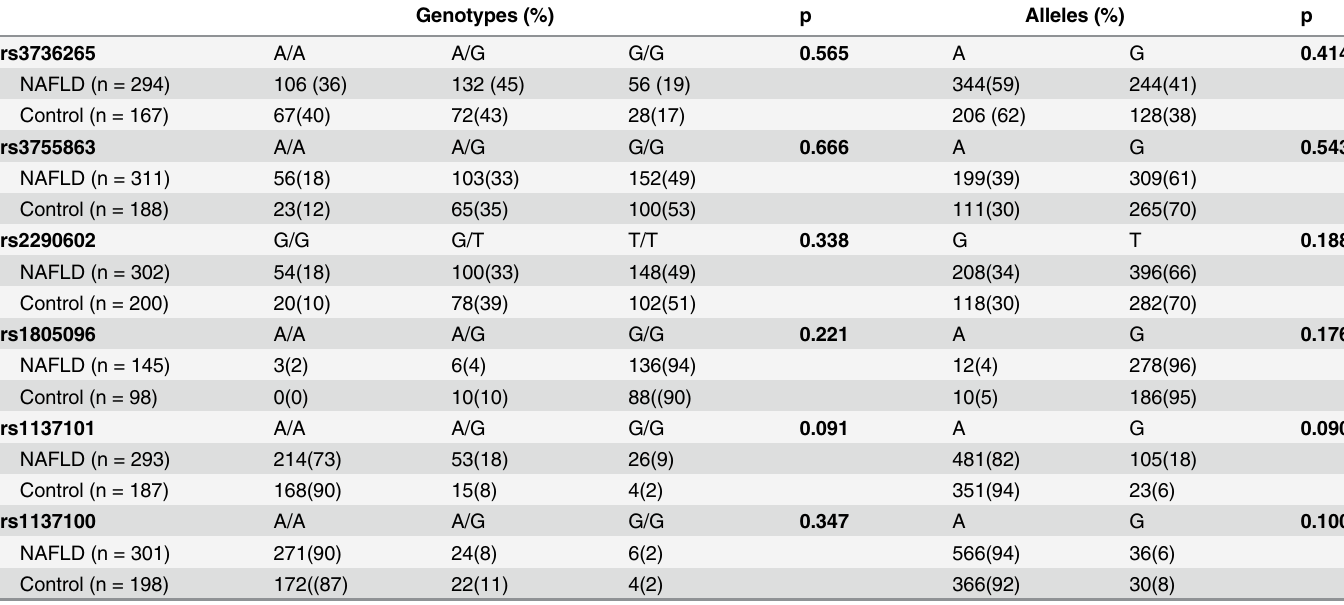
Table 2. The Genotypes and Allele Distribution of the PPARPGC1A (rs3736265, rs3755863, and rs2290602) and the LEPR (rs1805096, rs1137101, and rs1137100) Gene Polymorphisms in Case (Type 2 DM with NAFLD) and Control Groups (Type 2 DM without NAFLD). Genotypes (%)